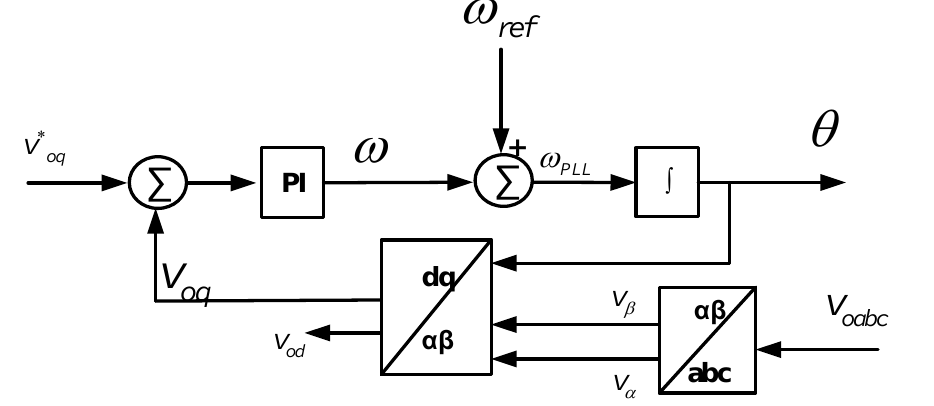
Figure 5. Phase locked loop ( PLL ).